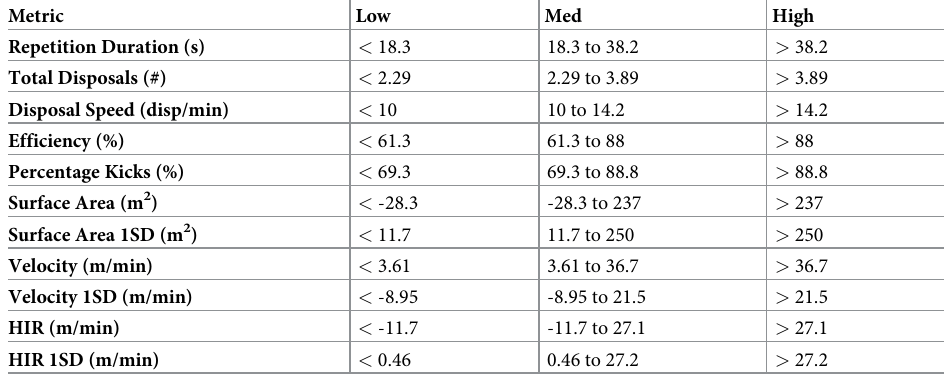
Table 2. Cut-off values used to discretise each behaviour metric.